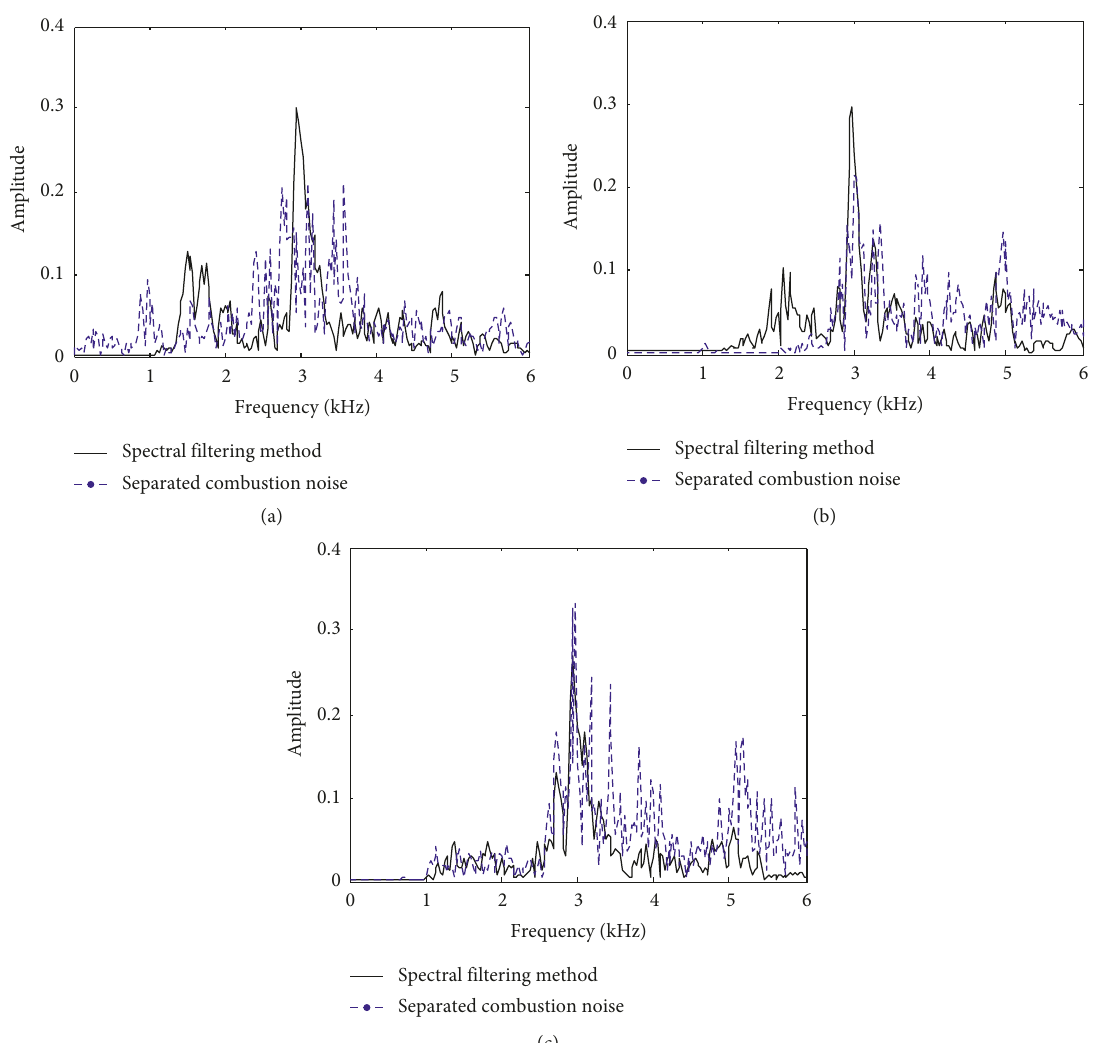
Figure 19: The compared results between the calculated combustion noise and the separated combustion noise. At (a) cylinder head top, (b) main slap side, and (c) vice slap